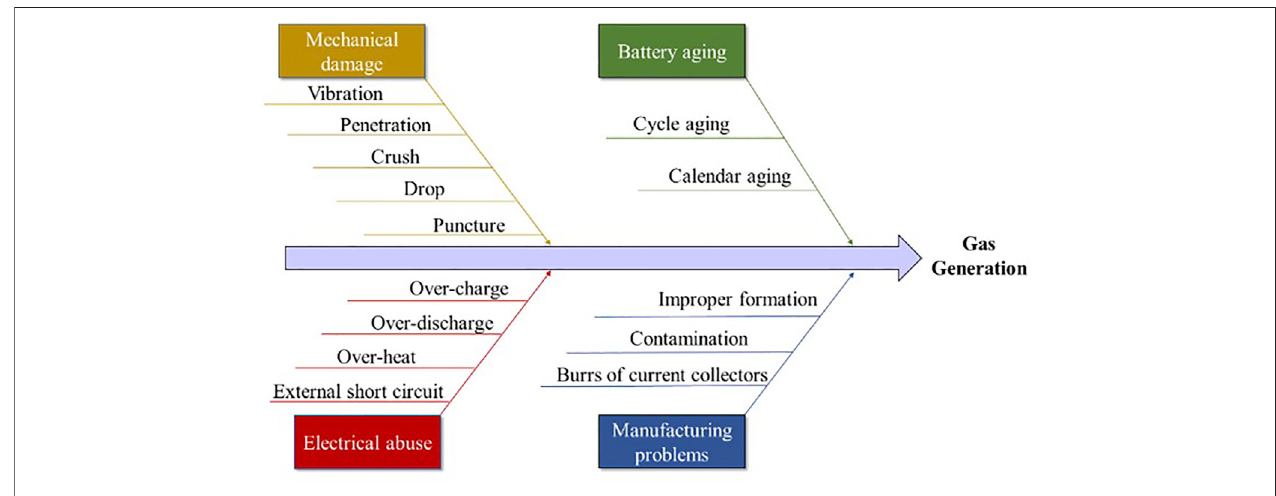
FIGURE 4 | Fishbone